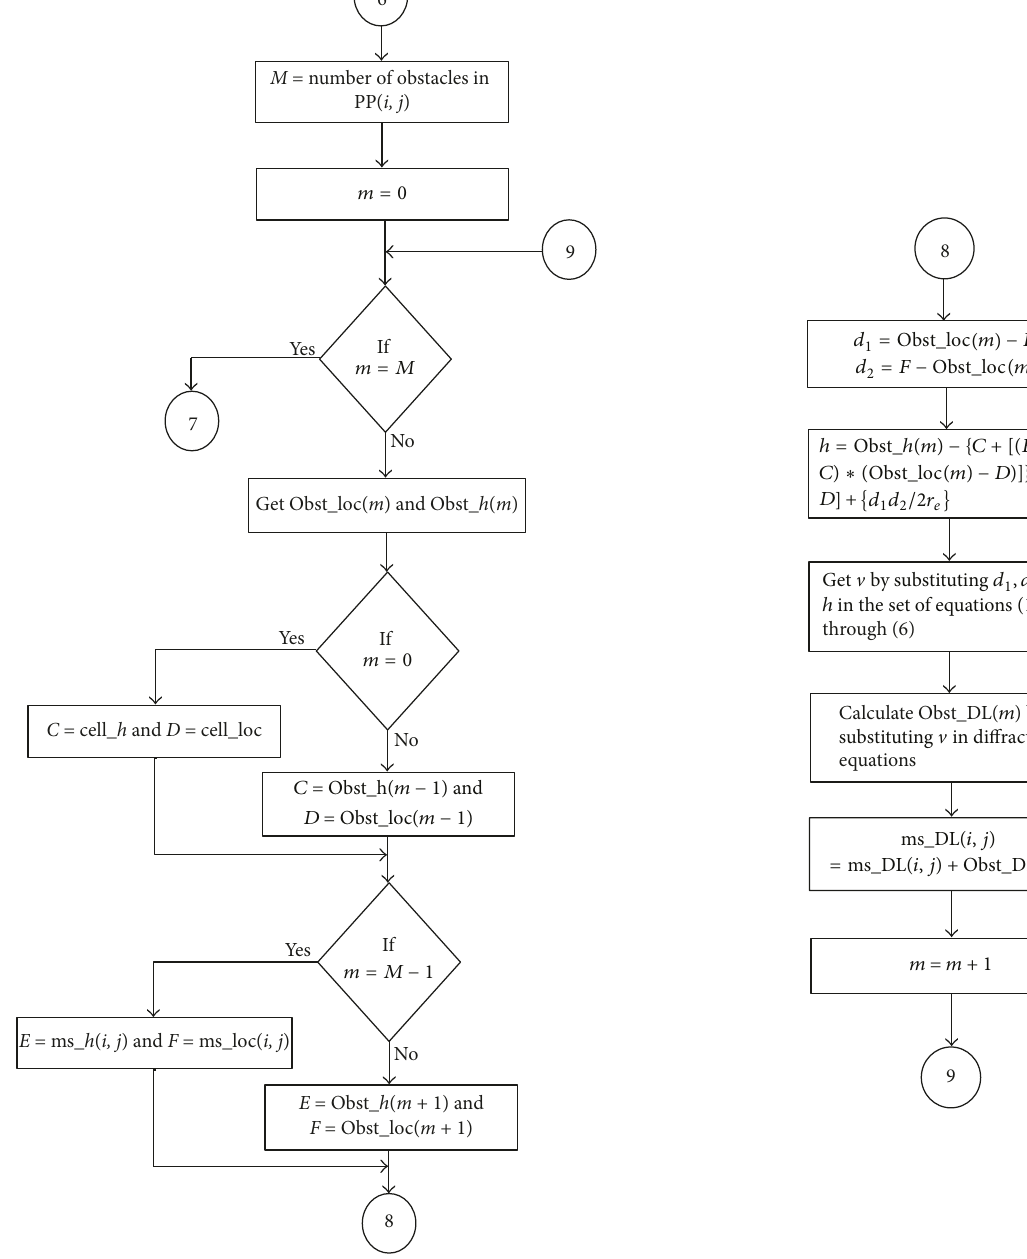
Figure 4: Multiple obstacles diffraction losses calculation algorithm flow